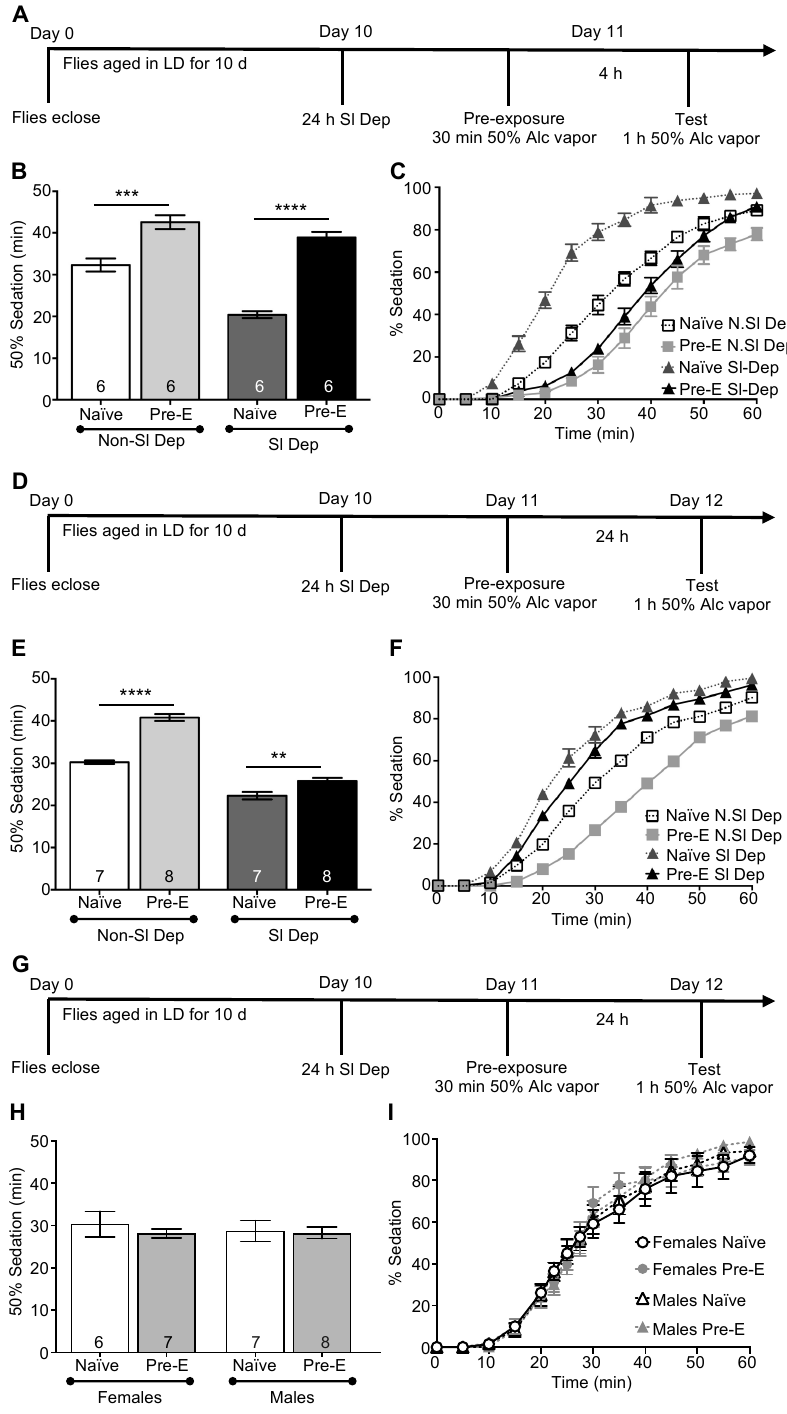
Figure 10. Sleep deprivation differentially affects short-term and long-term functional tolerance. ( A – C ) Effect of 24 h of sleep deprivation on short-term functional alcohol tolerance. ( A ) Wild-type CS flies were aged in 12:12 h LD cycle and sleep-deprived for 24 h on day 10. On day 11, flies were exposed to 50% alcohol vapor for 30 min and tested 4 h later by exposure to 50% alcohol vapor for 1 h with sedation measured. ( B ) Sleep deprivation for 24 h had no significant effect on the development of short-term acute alcohol tolerance. Both sleep-deprived and non-sleep-deprived flies exhibited alcohol tolerance (ANOVA: F 3,20 = 49.62, p < 0.0001). ( C ) Complete time course of alcohol exposure showing percent of flies exhibiting sedation for 10 d old sleep-deprived and non-sleep-deprived